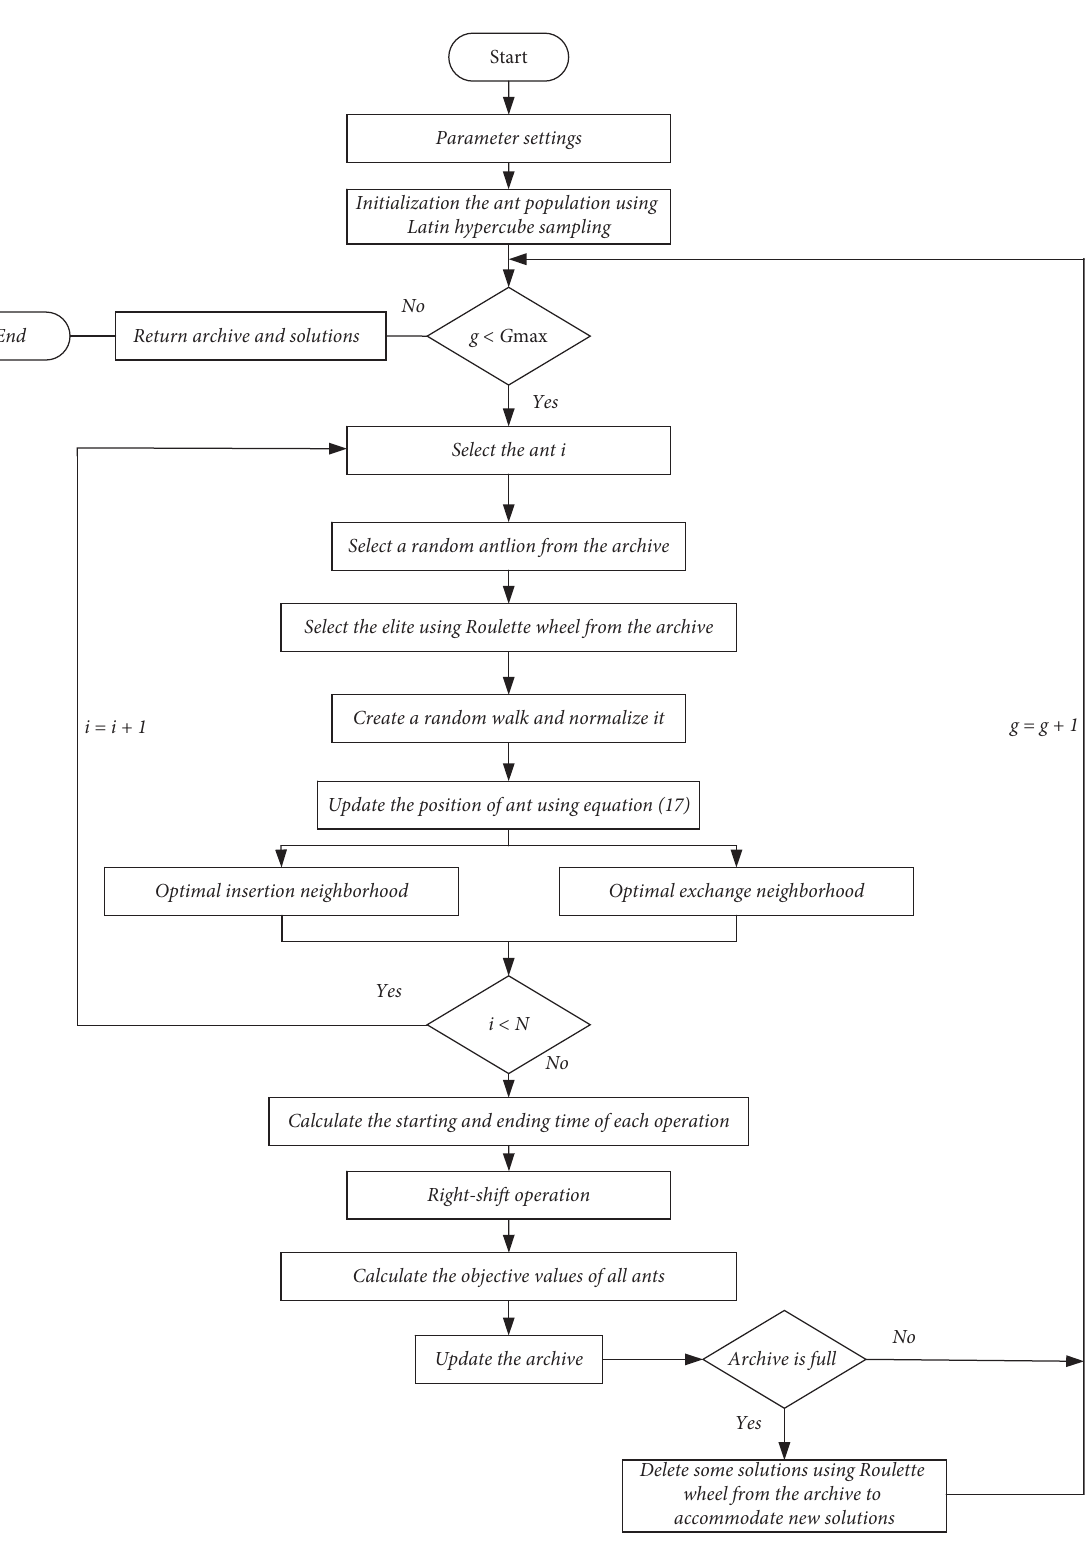
Figure 2: The flowchart for the proposed IMOALO